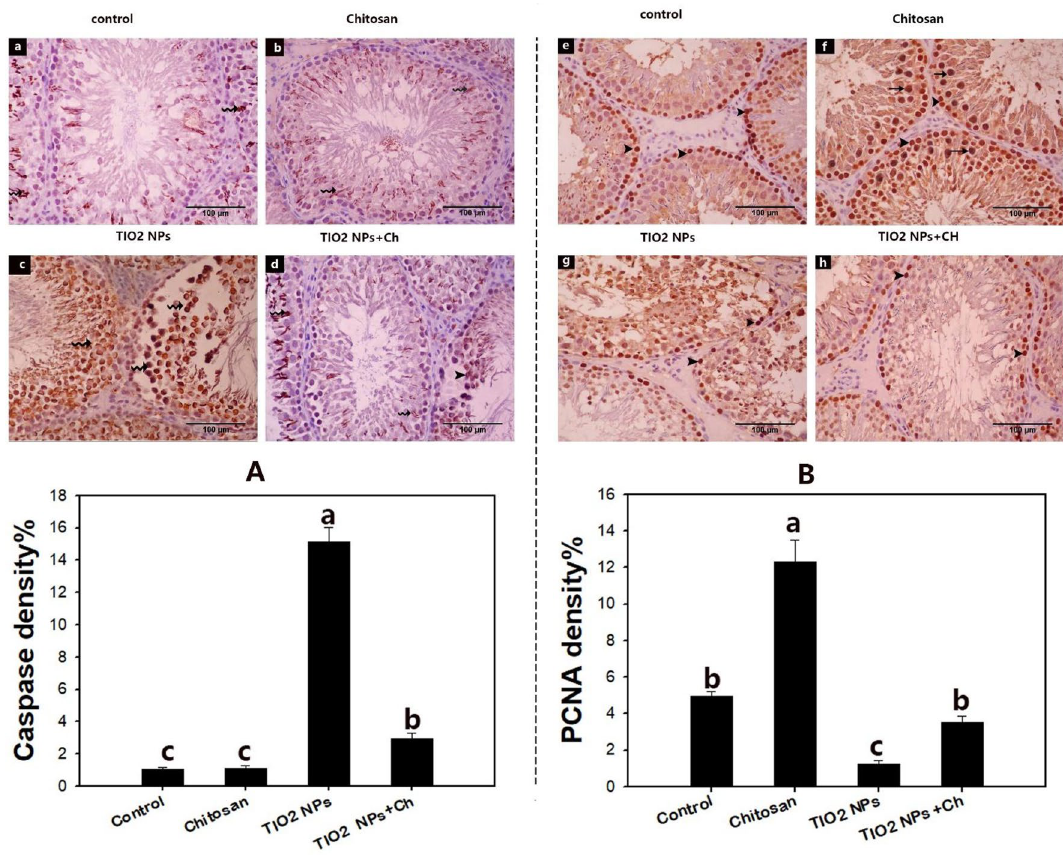
Figure 9. Photomicrograph of Enzyme immunohisto-chemical staining of paraffin sections from a testicular tissue for 1. caspase-3 immune expression (a, b, c and d) showing:only some hyphae of mature sperms in control ( a ) and chitosan ( b ) have positive reaction for caspase (arrow), most of seminiferous epithelium in TIO 2 NPs group ( c ) have positive reaction for caspase (arrow head). In TIO 2 NPs + Chitosan group, some hyphae (arrow) and few spermatocytes (arrow head) have positive reactions for caspase 2. PCNA immune expression ( e , f , g , h ) showing the PCNA expression was detected in the spermatogonia in all groups (arrow head) but in chitosan group was also detected in primary spermatocytes (arrow). ( e ) represent caspase-3 immune expression density, data are expressed as Mean ± SEM. The different letters (a, b, c) indicate significant difference between experimental groups. ( A , B ) represent caspase-3 and PCNA immune expression density respectively, data are expressed as Mean ± SEM. The different letters indicate significant difference ( P < 0.05) between experimental